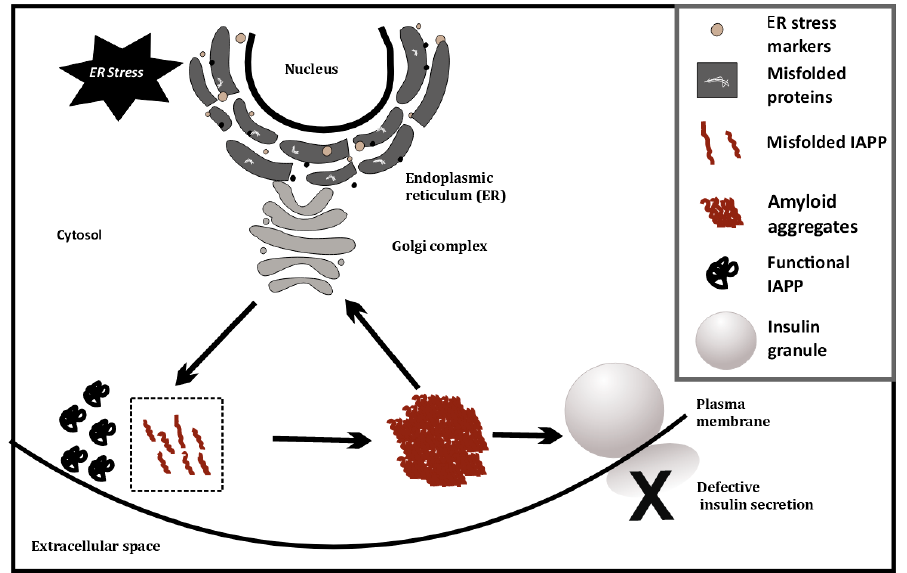
Figure 3. ER stress-induced misfolding of IAPP in β -cells, leading to amyloid formation.